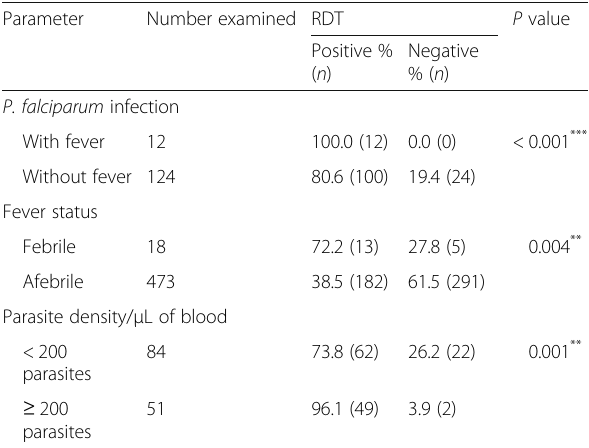
Table 4 P. falciparum infection presentation, fever status and RDT outcome Parameter